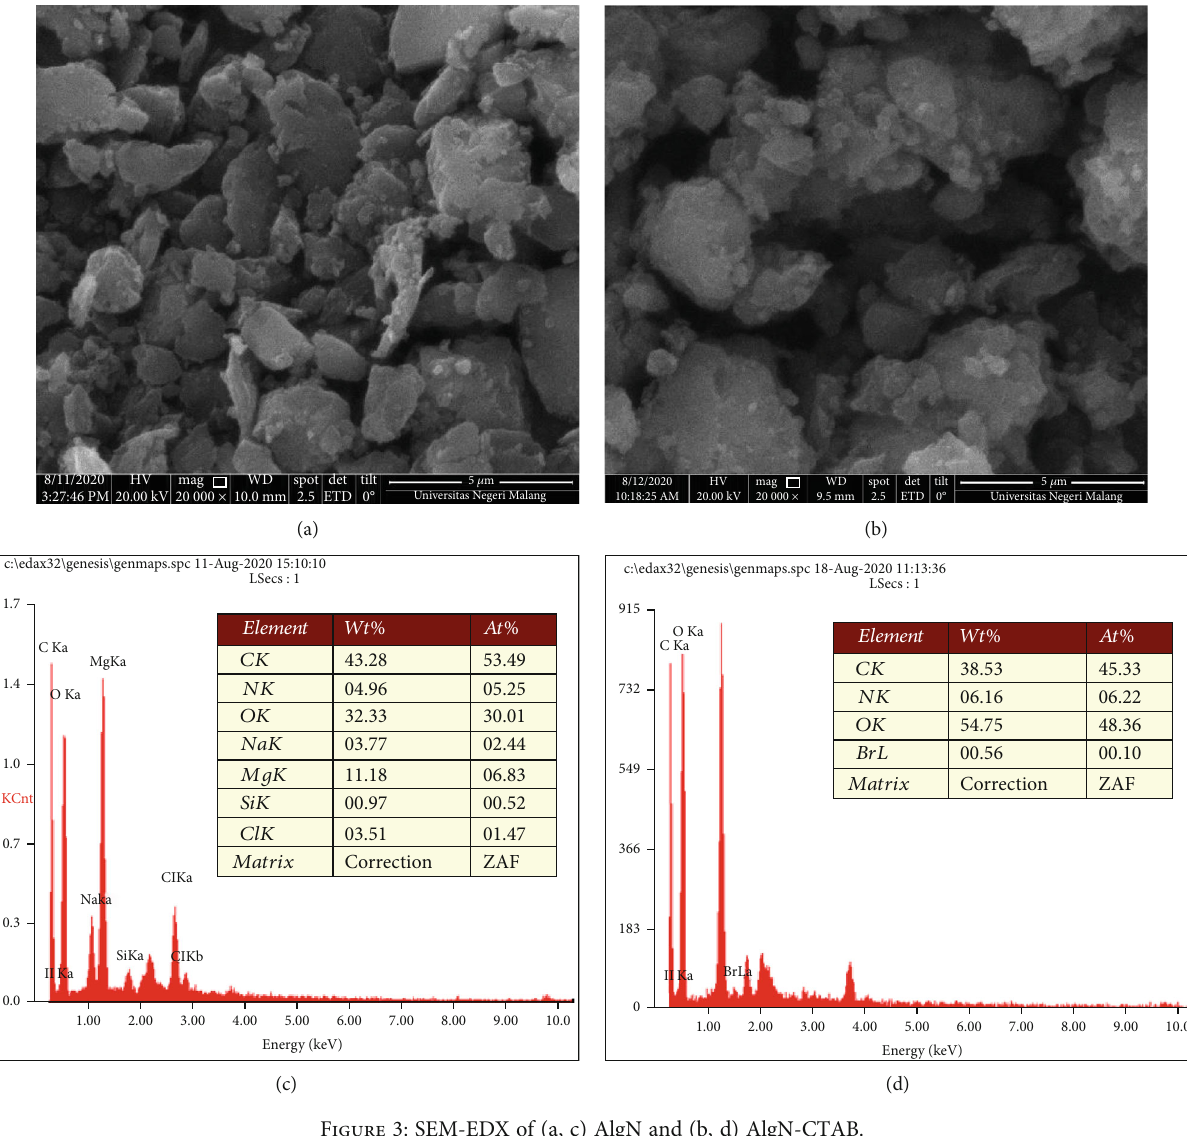
Figure 3: SEM-EDX of (a, c) AlgN and (b, d)